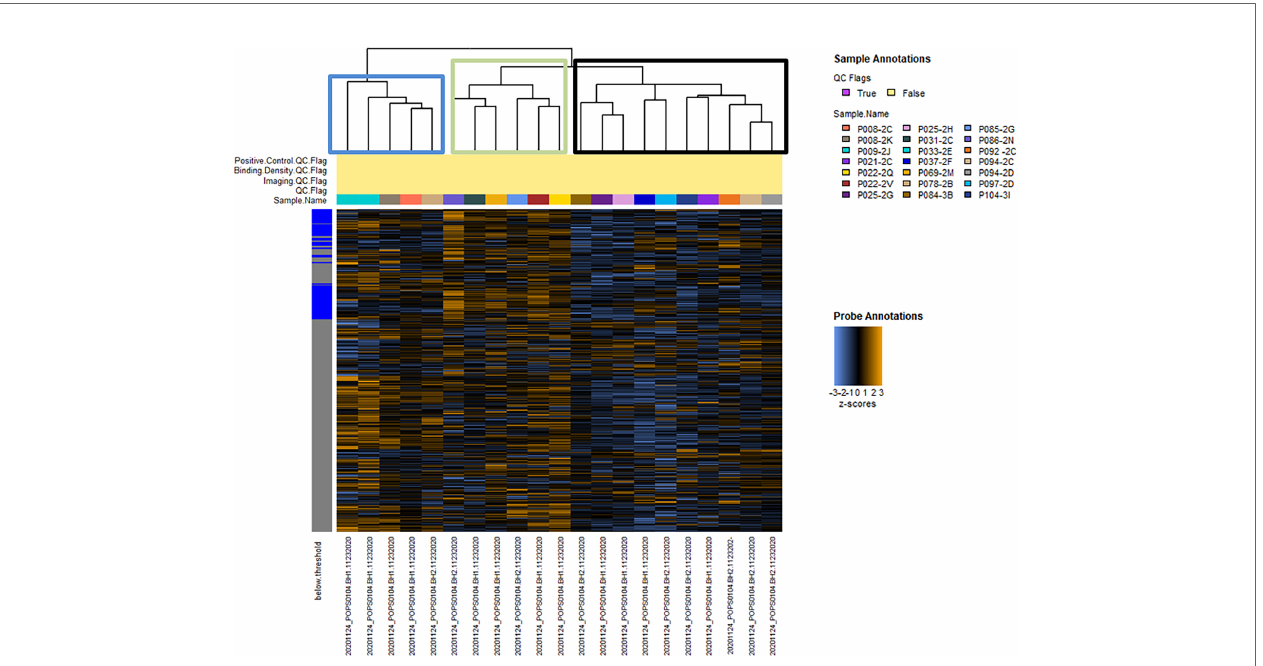
FIGURE 1 | Hierarchical clustering of normalized data between 21 hepatocellular carcinoma tumors from 17 patients. Hierarchical clustering of 760 tumor signaling genes. No samples were fl agged for quality control. Heatmap colors: blue indicates low expression, black indicates average, and orange indicates high expression. Tumors clustered into three nodes (HCC-1 - blue, HCC-2 - green, and HCC-3 - black boxes).